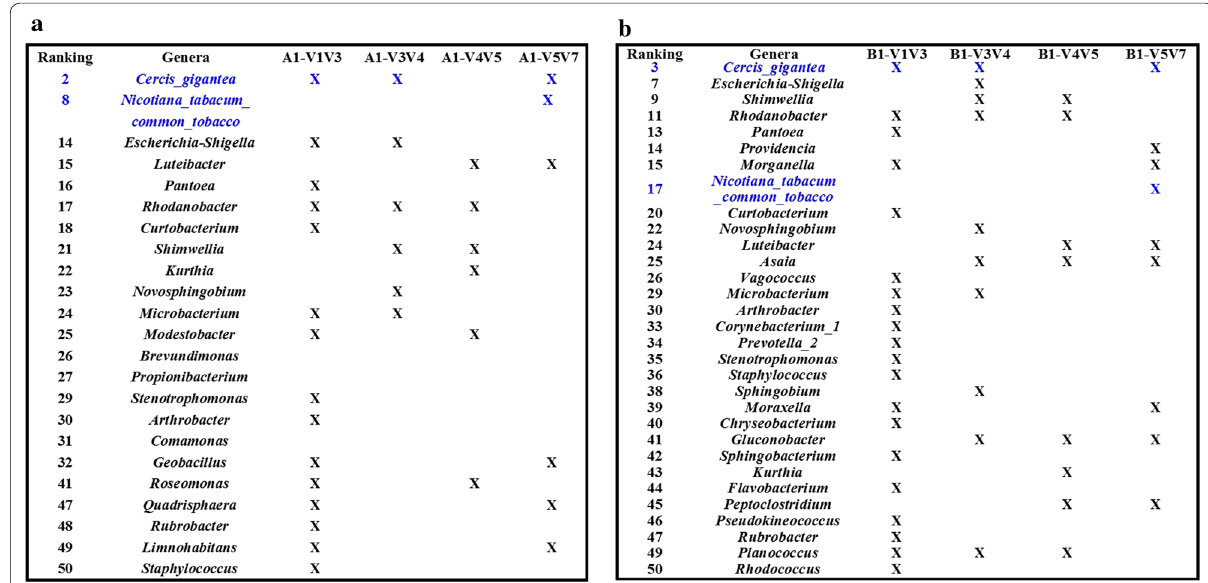
Fig. 3 Top 50 genera not detected for each amplification region. The rank was obtained based on the average relative abundance of genera for each amplification region; a sample A1 and b sample B1; genera not detected are marked with